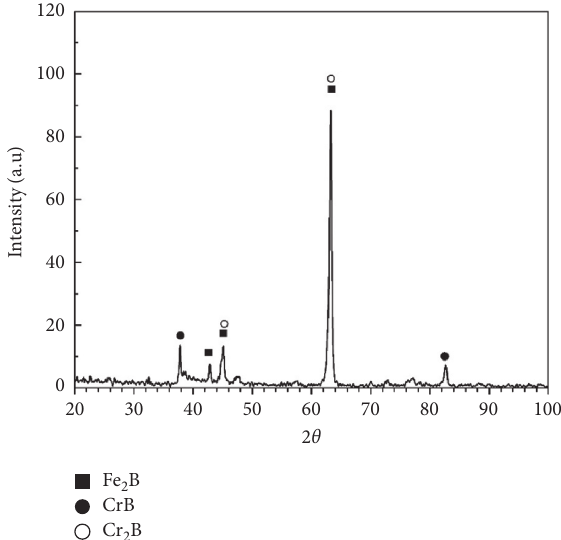
2 B layer and (b) substrate AISI W2.